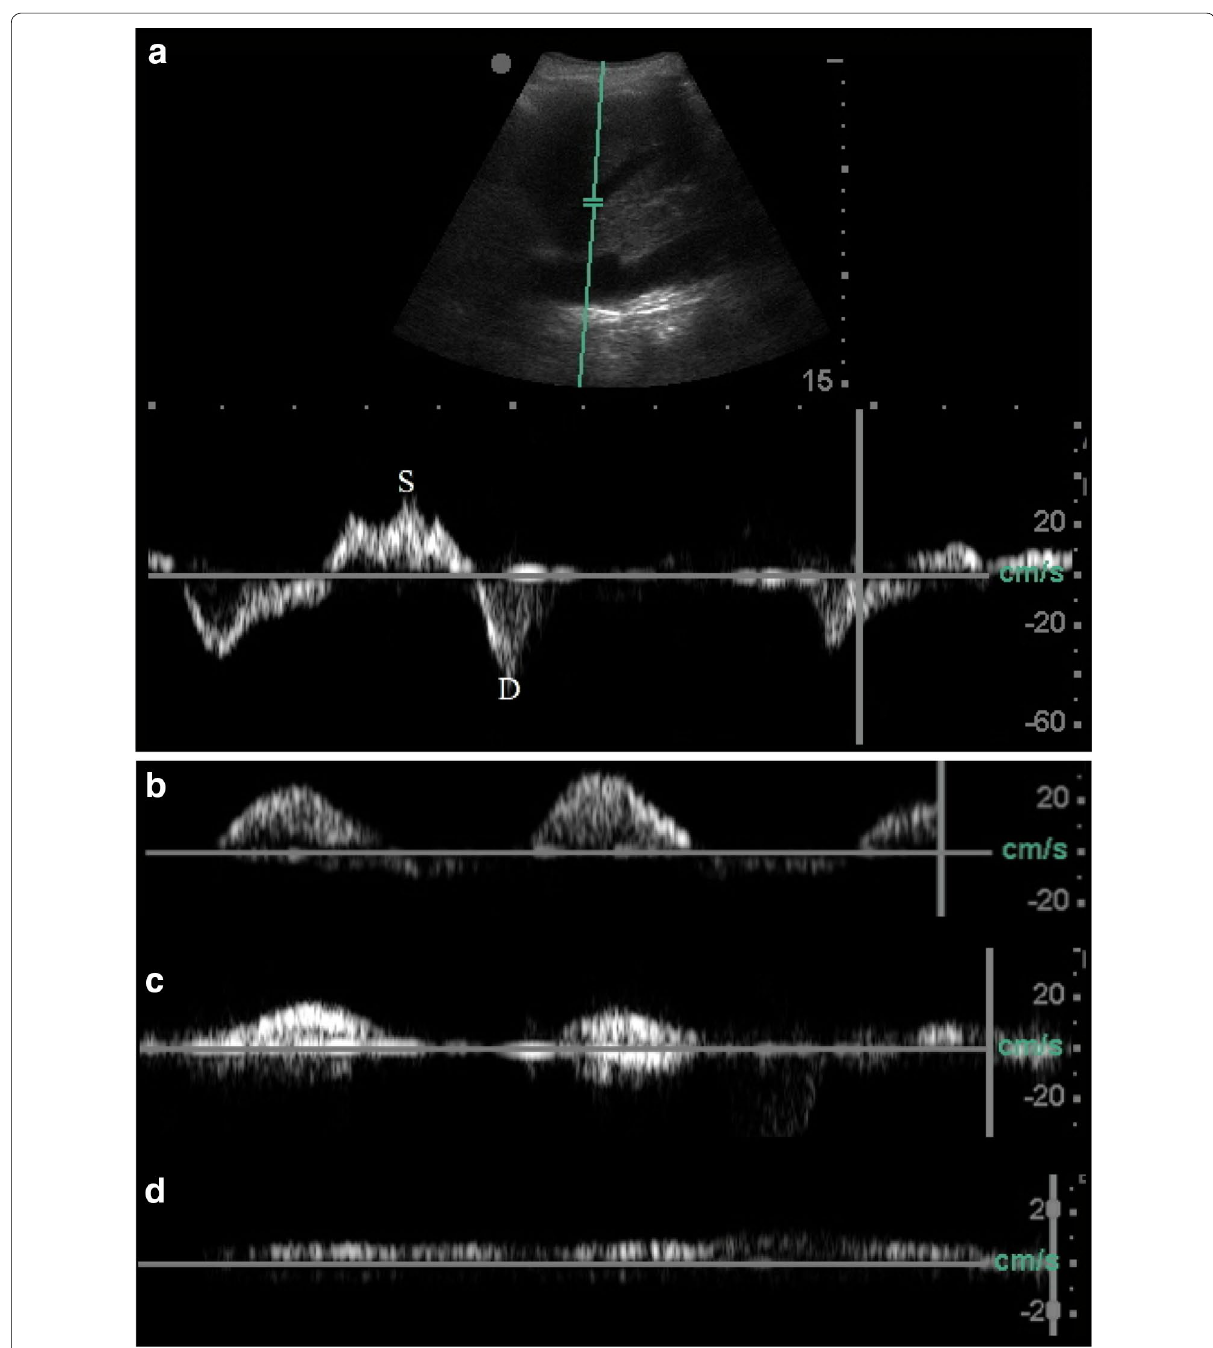
Fig. 1 a Doppler of the middle hepatic vein on Day 1 demonstrated S wave retrograde flow suggestive of tricuspid regurgitation and/or right heart failure. b Doppler of the right portal vein on Day 1 demonstrated pulsatile flow with intermittent flow cessation suggestive of venous congestion. c A net negative fluid balance of 1.9 L was achieved which resulted in on Day 2. d Then a net negative fluid balance of 4.9 L was achieved which resulted in the normalization to a continuous and anterograde phasic portal flow on Day